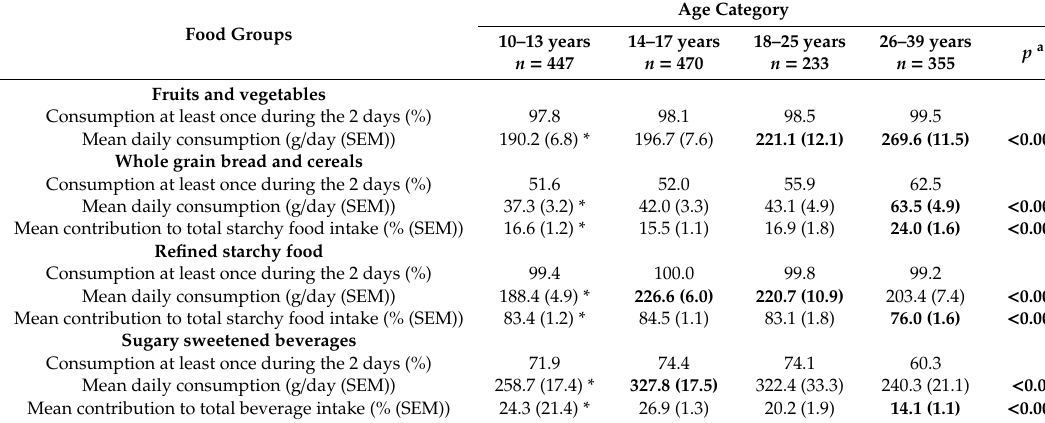
Table 1. Consumption, at least once during the two days of recall, mean daily consumption, and contribution to total intake of four food groups according to age group. Belgian food consumption survey